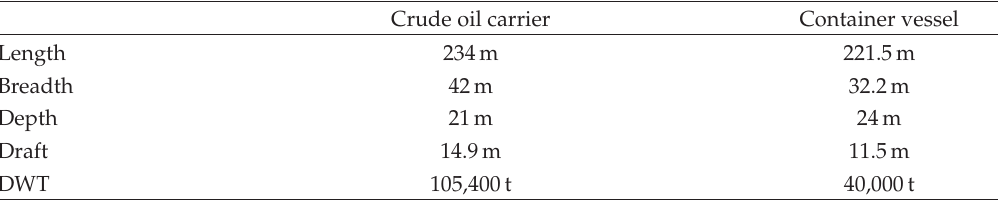
Table 2: Ships main